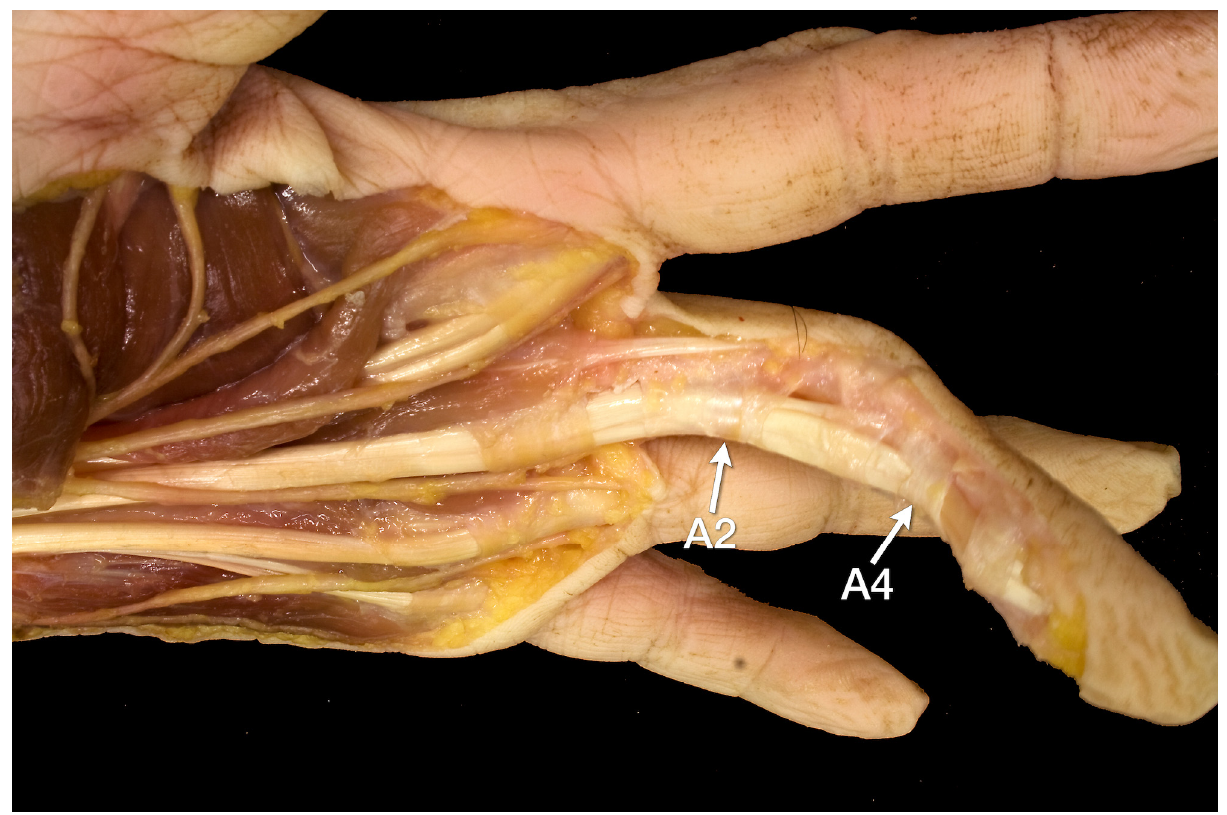
Figure 1. Preparation of the flexor tendons of the 3rd finger and their pulleys with view from oblique palmar. The A2 and A4 annular ligaments (arrows), which insert into the diaphyses of the proximal phalanx and middle phalanx, respectively, can be seen as very delicate structures.